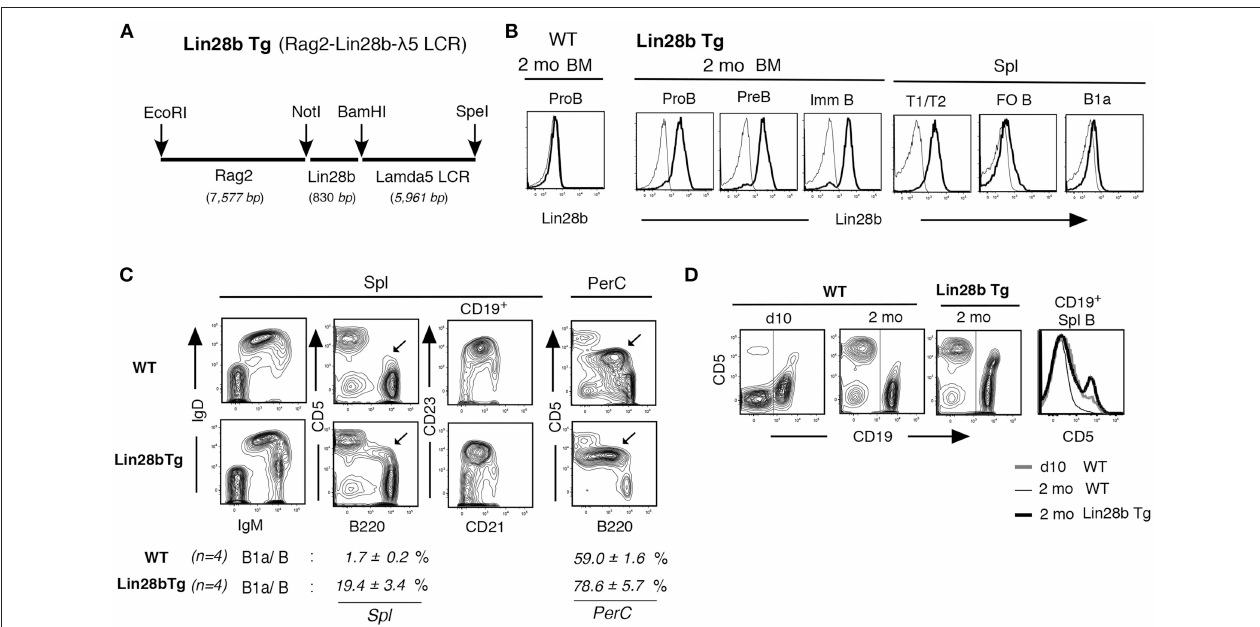
FIGURE 1 | Increased B1a cells in Lin28b Tg mice. (A) Rag2-Lin28b- λ 5 LCR construct for B lymphoid restricted Lin28b Tg expression. (B) Cytoplasmic staining of 2 mo Lin28b Tg (and WT) BM B-lineage and spleen transitional T1/T2, FO B, and B1a cells. Rabbit anti-Lin28b + anti-rabbit Ab staining (high black), vs. anti-rabbit alone (–) as a control. WT mouse B-lineage and B cells were all Lin28b negative. (C) 2 mo adult Lin28b Tg and WT mouse spleen and PerC. B220 lo CD5 + B1a cells are marked. B1a/B; percentage of B1a cells in total B cells. B1a cell increase was also observed in Lin28b Tg.B6 (C57BL/6) mice. (D) CD5 level comparison in spleen B cells (CD19 + , marked) between WT (d10 and 2 mo) and Lin28b Tg (2 mo)